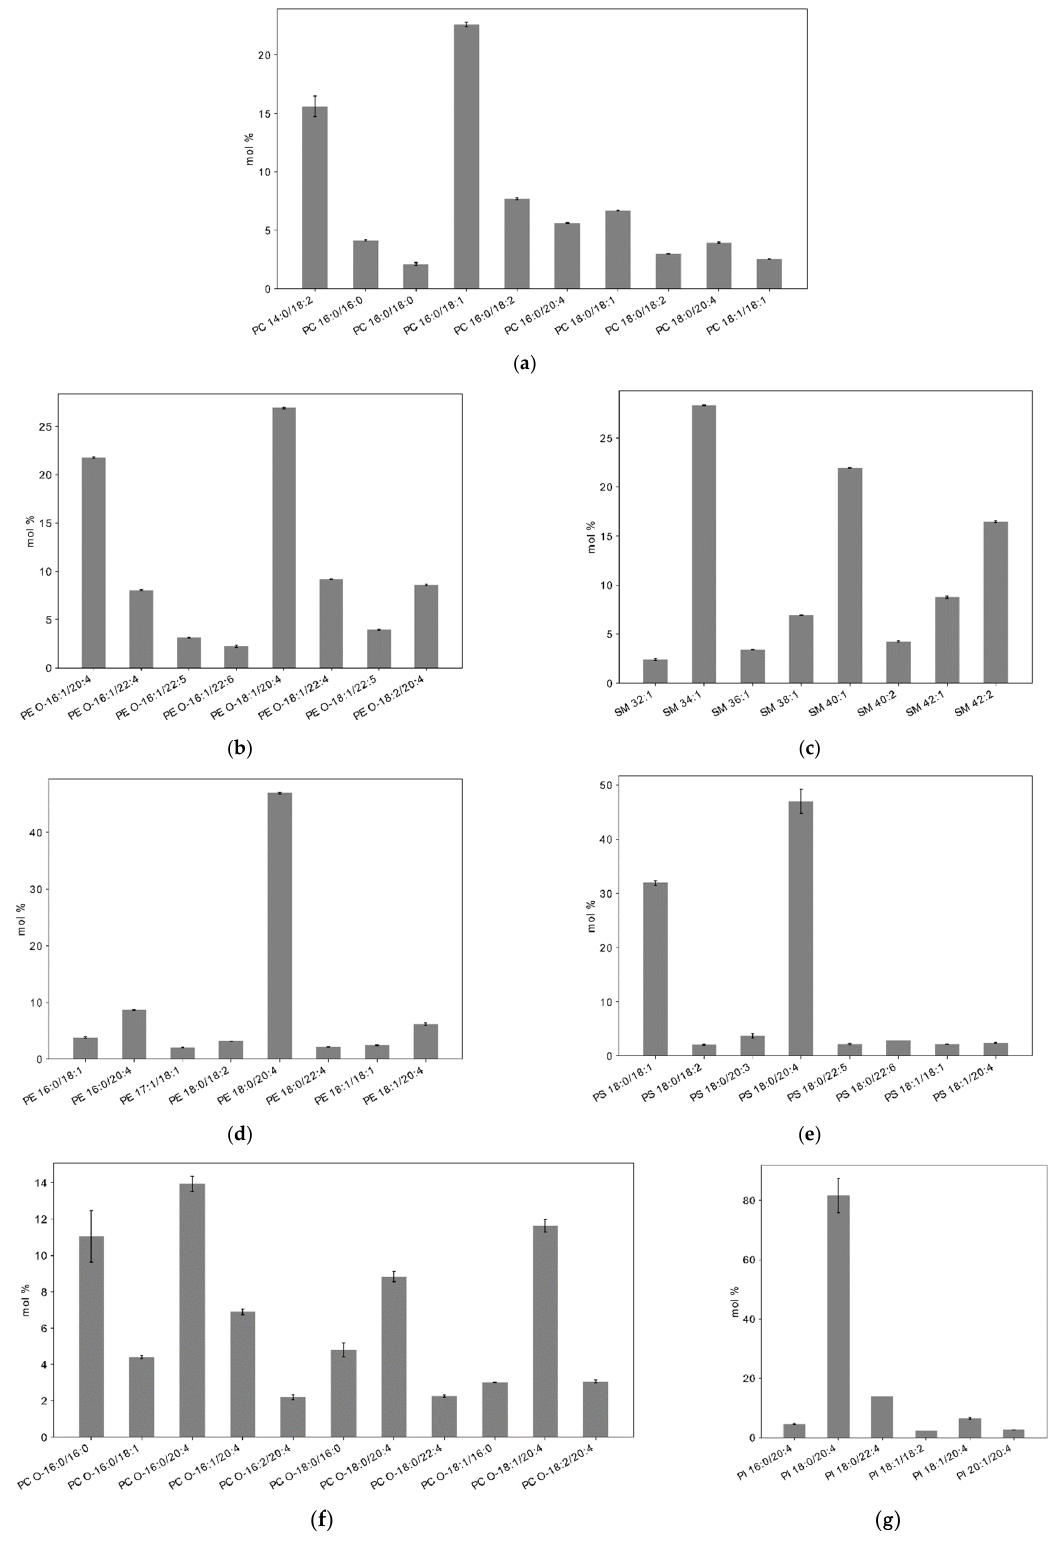
Figure 2. Lipid composition of the plasma membrane of resting platelets with ( a ) Phosphatidylcholines (PC), ( b ) Phosphatidylethanolamines ether (PE O-), ( c ) Sphingomyelins (SM), ( d ) Phosphatidylethanolamines (PE), ( e ) Phosphatidylserines (PS), ( f ) Phosphatidylcholines ether (PC O-) and ( g ) Phosphatidylinositols (PI). Results are expressed in mol% inside each sub-class of lipids. Lipids below 2% of its sub-classes were not represented. Complete values are available in supplementary data (Table S1).